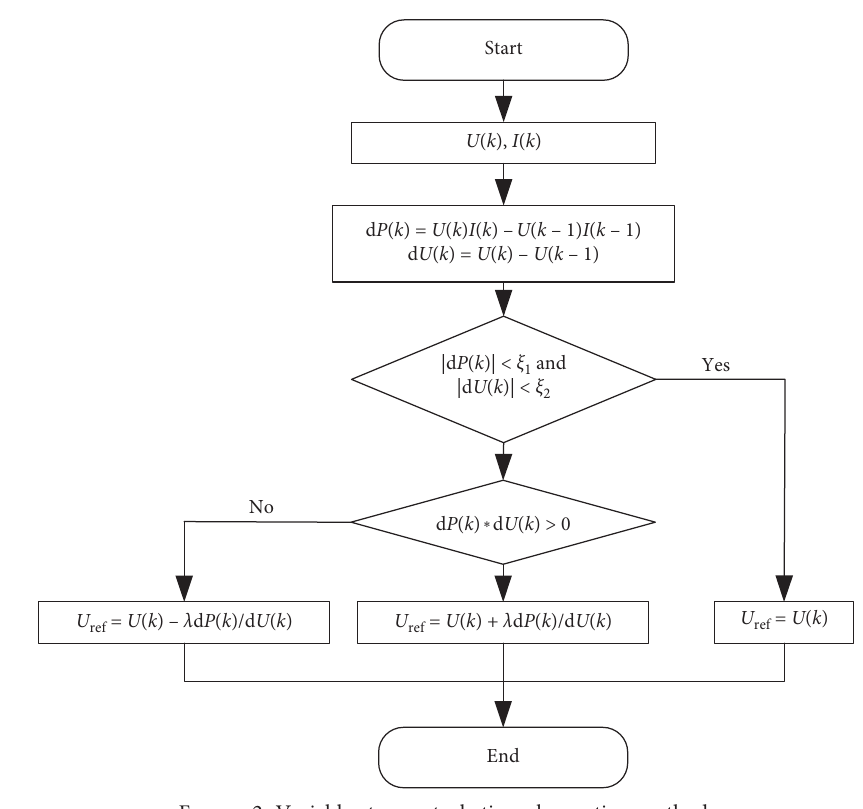
Figure 2: Variable step perturbation observation method.